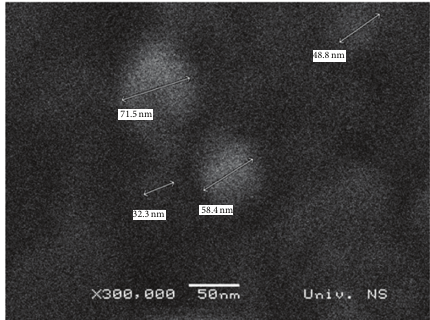
Figure 2: SEM image of fullerenol/benzalkonium chloride